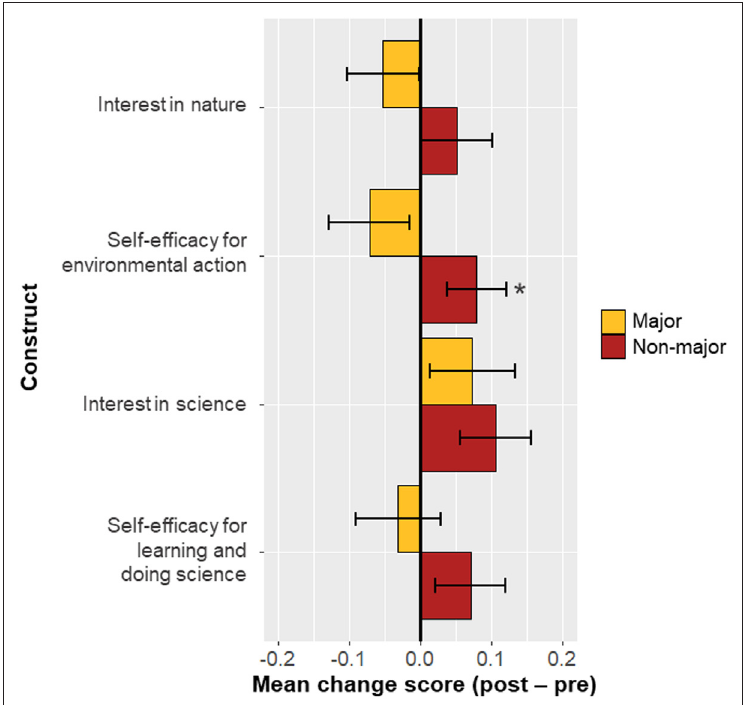
Figure 1 Mean change scores (post-score minus pre-score) by student major following citizen science participation across both years (2019 and 2020). Major = agriculture or natural resource majors (n = 69), Non-Major = all other majors (n = 126). Change scores shown for all four constructs of interest. Scores above 0 denote positive change. Asterisk (*) denotes statistical significance of score change for a construct based on factorial ANOVA at p = 0.1. Error bars represent standard error of the mean change scores.